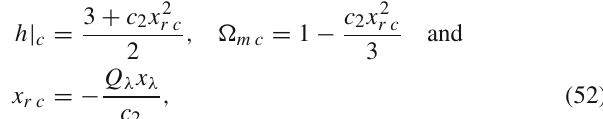
to various w eff at late time. In the plots, we initially set y r = 10 − 11 according to the φ MDE point, so that the value of (cid:10) m can be larger than unity before reaching the field- dominated point. However, if c 4 is sufficiently small, e.g., c 4 = 5 . 6 × 10 − 3 for model IV, (cid:10) m can be less than